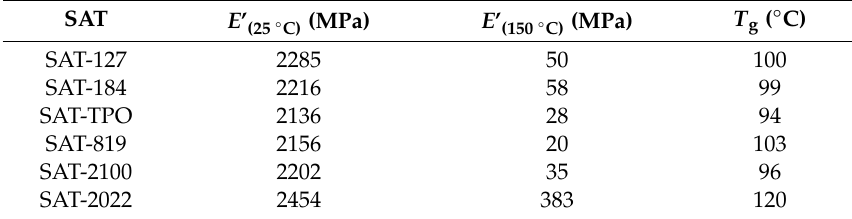
Figure 10. Tangens delta for thermally cured SATs. Table 6. Characteristic storage modulus ( E ’) values at room temperature and 150 ◦ C and the glass transition temperature ( T g ) values for cured SATs based on